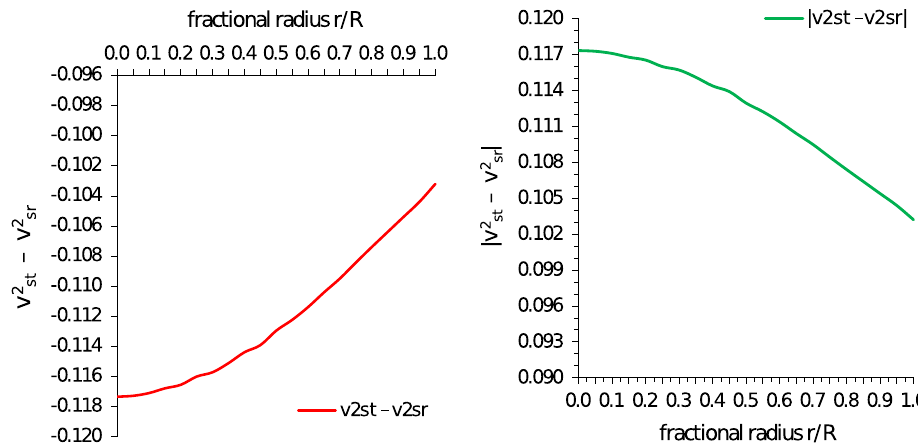
− V 2 | V 2 − V 2 | for RX J 1856-37. For plotting this figure we have employed the sr and sr st st